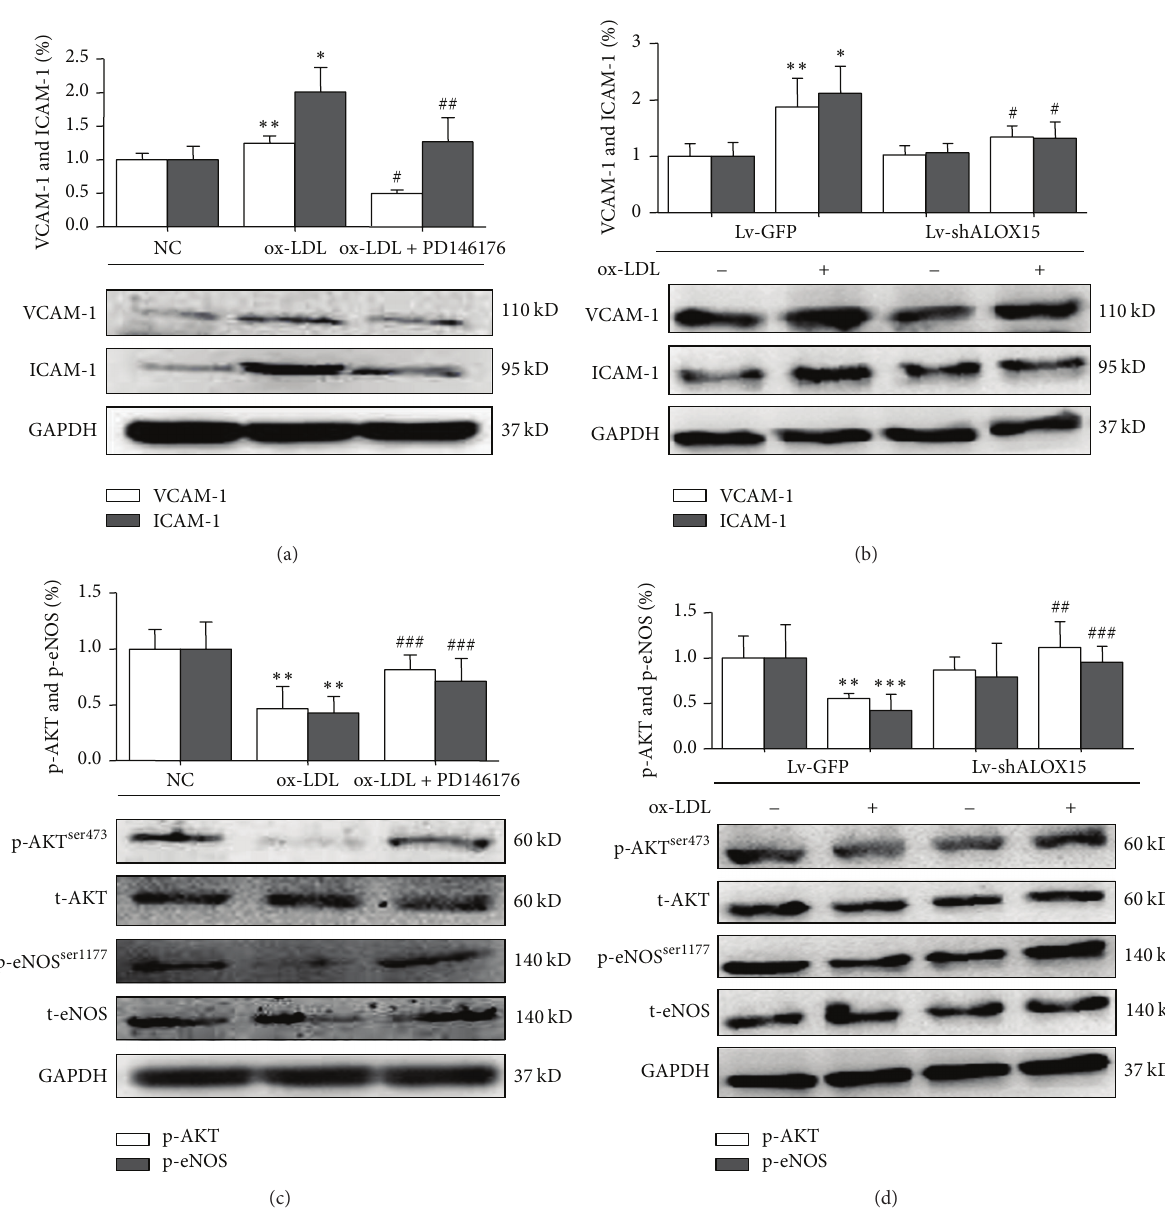
Figure 4: Effects of PD146176 (20 𝜇 M) and Lv-shALOX15 on expression levels of VCAM-1, ICAM-1, AKT, and eNOS in HUVECs. (a) and (b) Western blot analysis of VCAM-1/ICAM-1 in HUVECs. (c) and (d) Western blot analysis of AKT/eNOS in HUVECs. Results are expressed as mean ± SD. NC: normal control group. ∗ 𝑃 < 0.001 , ∗∗ 𝑃 < 0.01 , and ∗∗∗ 𝑃 < 0.05 versus the NC group; # 𝑃 < 0.001 , ## 𝑃 < 0.01 , and ### 𝑃 < 0.01 versus the ox-LDL group or ox-LDL + Lv-GFP group. 𝑁 = 5 per group.